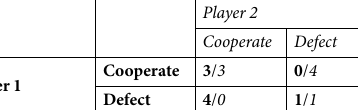
which resulted in tilting the tray towards themselves, each received one reward (defect-defect). If one player pulled and the other pushed the handle, which resulted in tilting both trays towards the player who pulled only, the player who pulled received all four rewards (highest individual payoff) while the other received nothing (low- est individual payoff; defect-cooperate). Finally, if both players chose to push the handle, which resulted in tilting the tray towards the partner, each player received three rewards (highest combined payoff; cooperate-cooperate). Table 1 shows the payoff matrix used in the Prisoner’s Dilemma Game. General procedure.